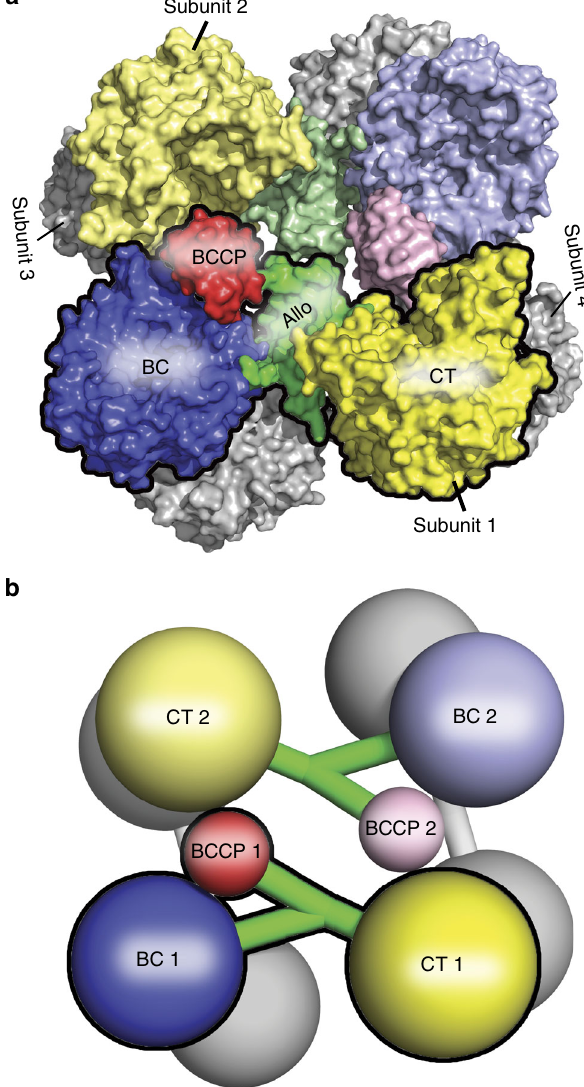
Fig. 1 The quaternary structure of RePC. The subunits in RePC (2QF7) are organized to include two subunits on the upper layer and two subunits on the lower layer of the tetramer. The individual domains on the top layer are colored in blue for the biotin carboxylase (BC) domain; yellow for the carboxyltransferase (CT) domain; red for the biotin carboxyl carrier protein (BCCP) domain and green for the allosteric domain. The two subunits on the lower layer of the tetramer are colored entirely in gray for clarity. A space fi lling representation is shown in a , while a simpli fi ed cartoon representation of the subunit domains is shown in